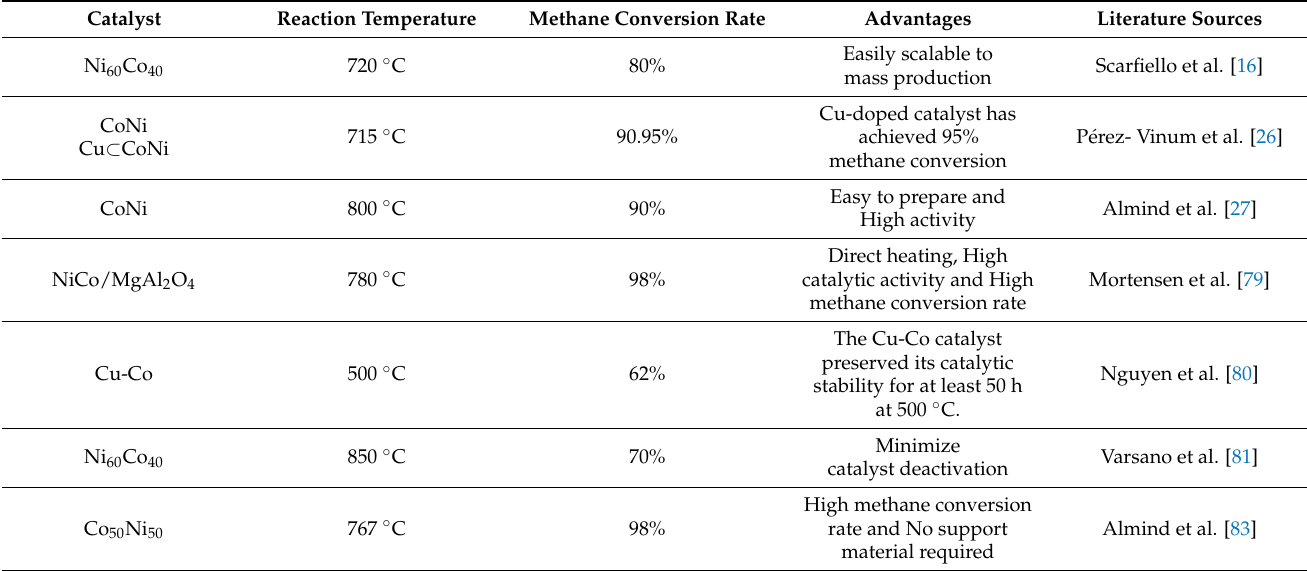
Table 1. Methane reforming to hydrogen catalyst current status of induction